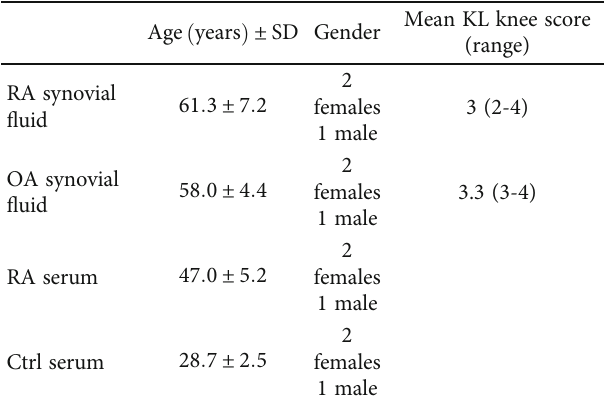
Table 1: Patient data for samples used in cell